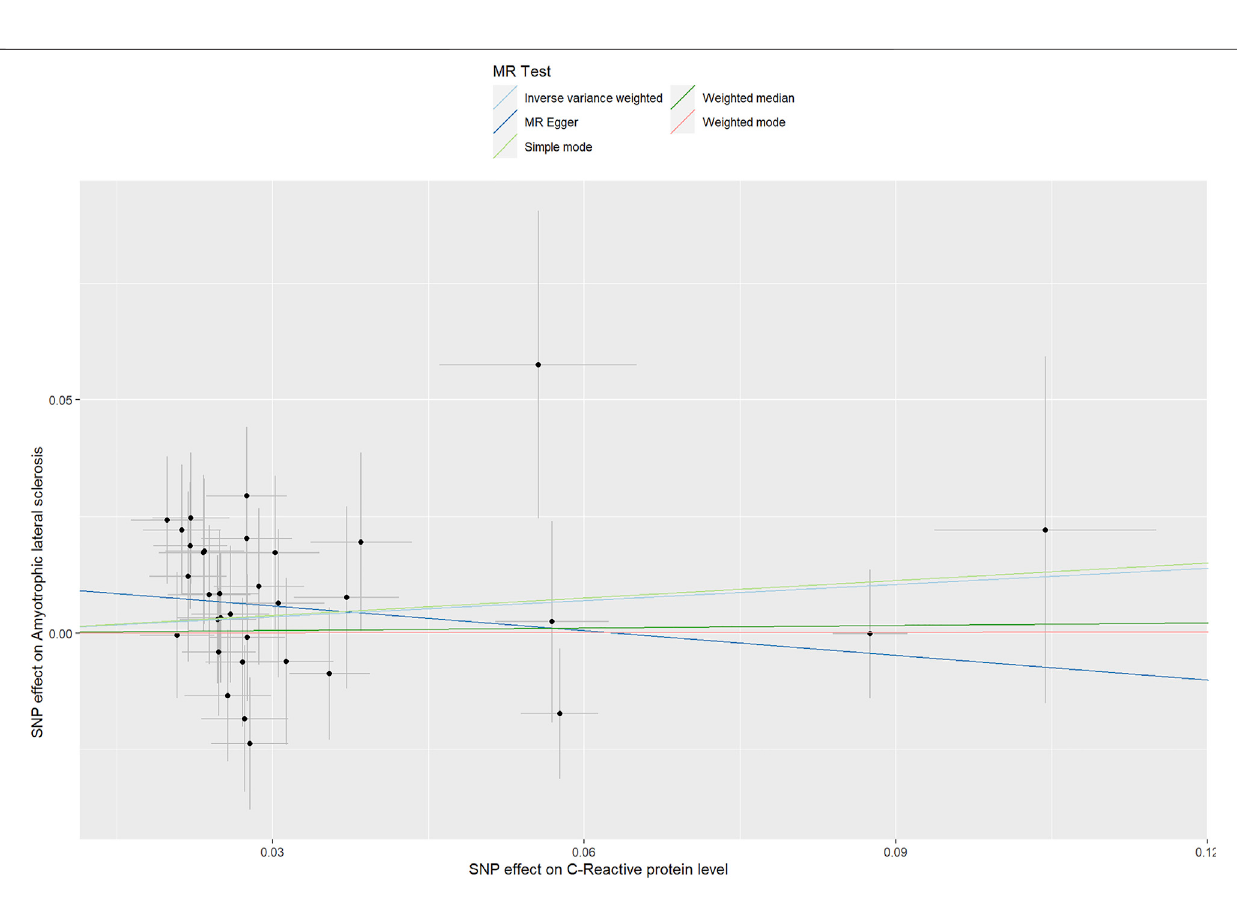
Frontiers in Genetics |